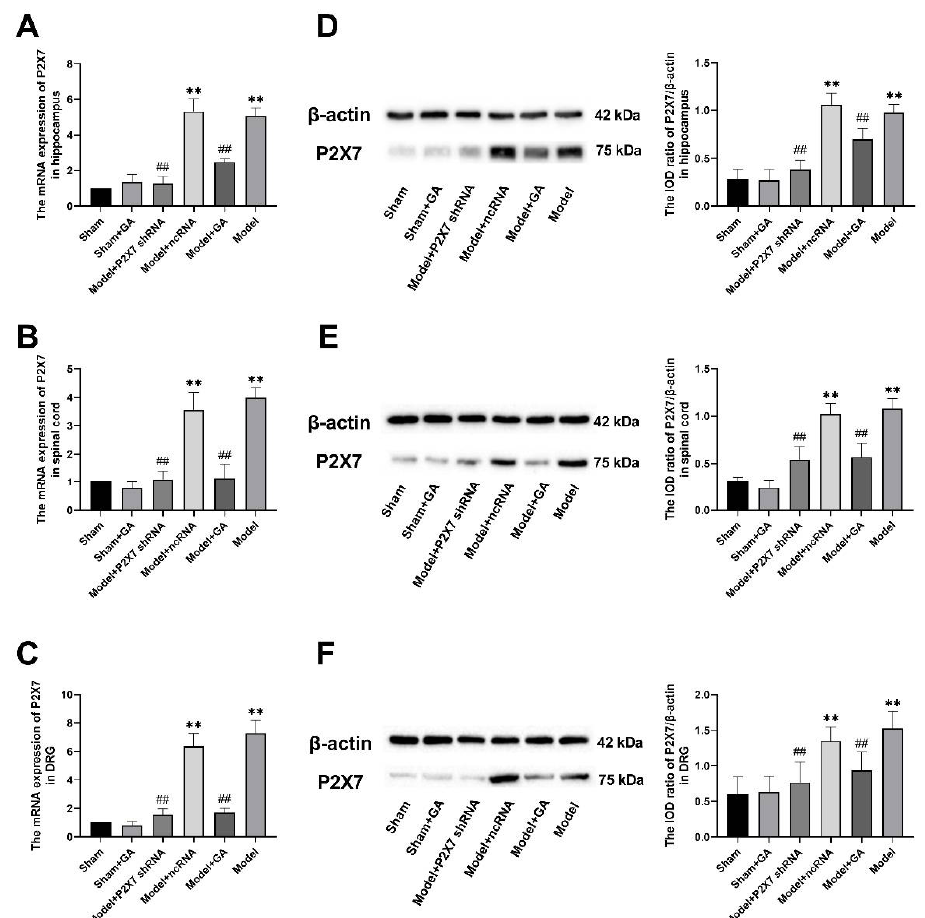
Figure 5. The expression of P2X7 receptor mRNA in the hippocampus was confirmed by qRT-PCR (F(5,30) = 131.475, p < 0.001) ( A ). The expression of P2X7 receptor mRNA in the spinal cord was confirmed by qRT-PCR (F(5,30) = 84.012, p < 0.001) ( B ). The expression of P2X7 receptor mRNA in the DRG was confirmed by qRT-PCR (F(5,30) = 31.043, p < 0.001) ( C ). β -Actin was used as the housekeeper gene in all qRT-PCRs. The relative expression of the P2X7 protein was detected by Western blotting in the hippocampus (F(5,30) = 68.997, p < 0.001) ( D ), spinal cord (F(5,30) = 62.397, p < 0.001) ( E ), and DRG (F(5,30) = 15.084, p < 0.001) ( F ). Values are means ± SEM. N = 6 per group. ** p < 0.01 vs. sham group; ## p < 0.01 vs. model group.